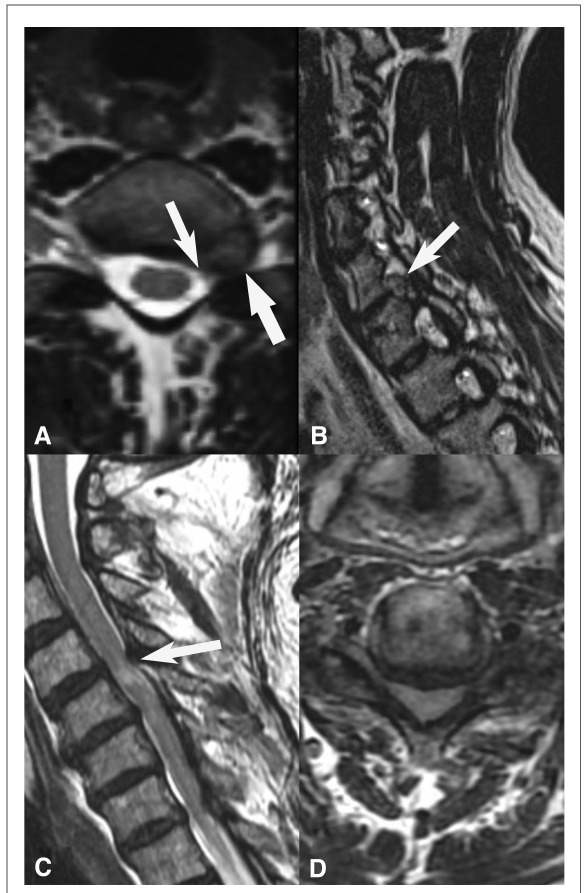
FIGURE 2 MRI of two different patients that had a history of ulnar nerve compression with a diagnosis resulting in surgical treatment of the nerve compression disorder at the elbow, with and without another nerve compression disorder. ( A,B ) T2W axial and sagittal images showing left sided foraminal disc herniation C7-Th1 (thick arrow) with compression of the C8-nerve root (thin arrow, A). ( C,D ) T2W sagittal and axial images of another patient with severe central stenosis with total obliteration of CSF spaces around the spinal cord ( D ) and signal changes in the spinal cord at level C4-C5 (thin arrow C).